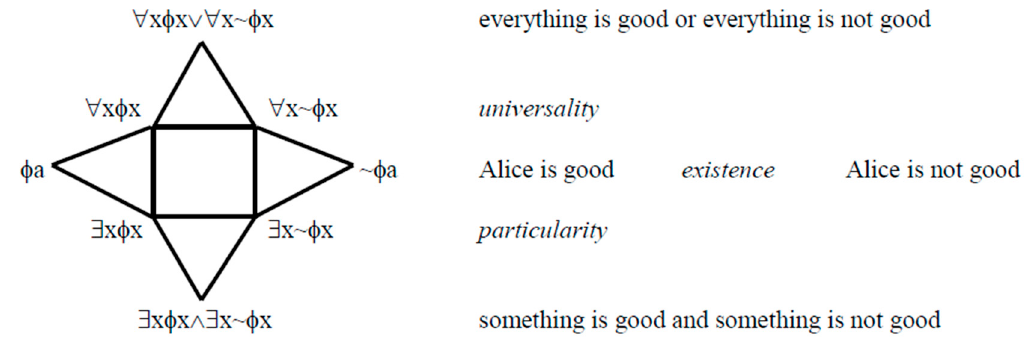
Figure 5. The octagon of quantification.